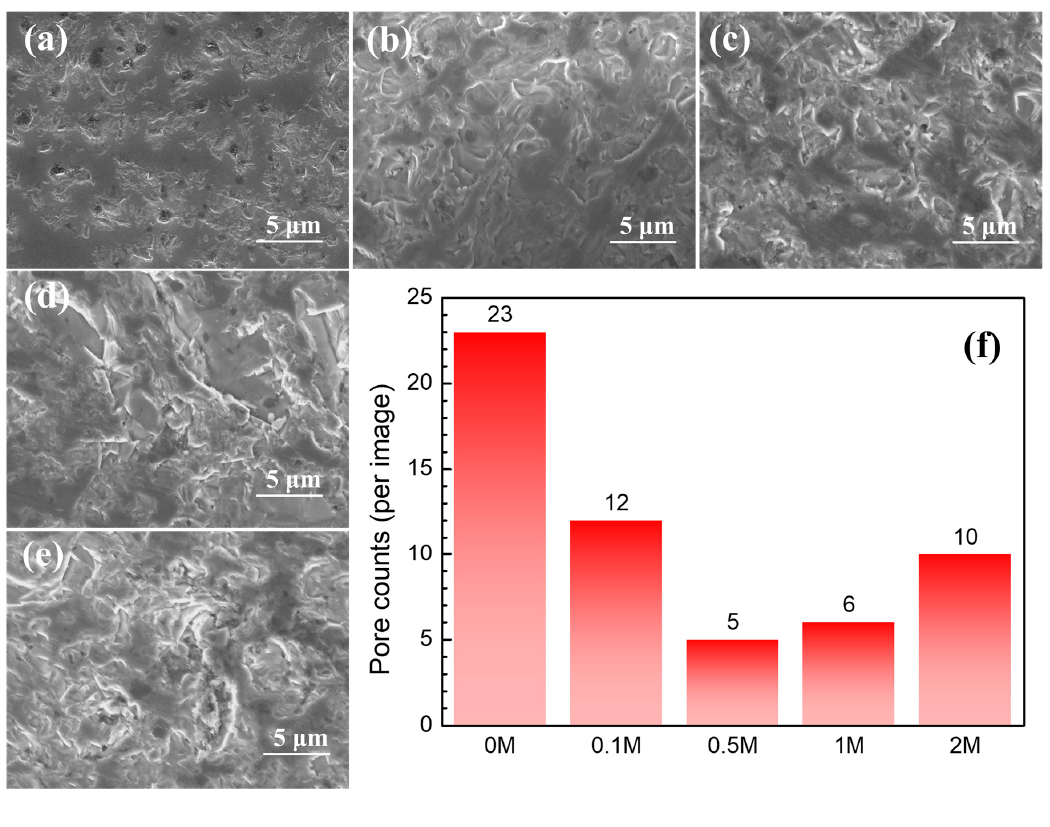
Figure 4. E ff ect of graphene doping on microstructure of SiC ceramics: ( a ) 0 M, ( b ) 0.1 M, ( c ) 0.5 M, Figure 4. Effect of graphene doping on microstructure of SiC ceramics: ( a ) 0M, ( b ) 0.1M, ( c ) 0.5M, ( d ) ( d ) 1 M, ( e ) 2 M and ( f ) pore counts in di ff erent samples (randomly areas with the same scanning 1M, ( e ) 2M and ( f ) pore counts in different samples (randomly areas with the same scanning size) With the doping amount of graphene in the 0.5M sample (Figure 4c) further increasing, the pores became smaller, the sample was denser, and the number of grain boundaries that could be observed increased. In the 1M sample (Figure 4d), the number of grain boundaries observed further increased, and the number of pores also increased slightly in the uneven sections from the intercrystalline fracture surfaces. When the graphene amount increased to 2 wt.%, more grain boundaries and pores were observed in the 2M sample (Figure 4e). The section was almost all intergranular fracture, with a grain size of 1–5 μ m, which was consistent with the size of SiC powder particles.